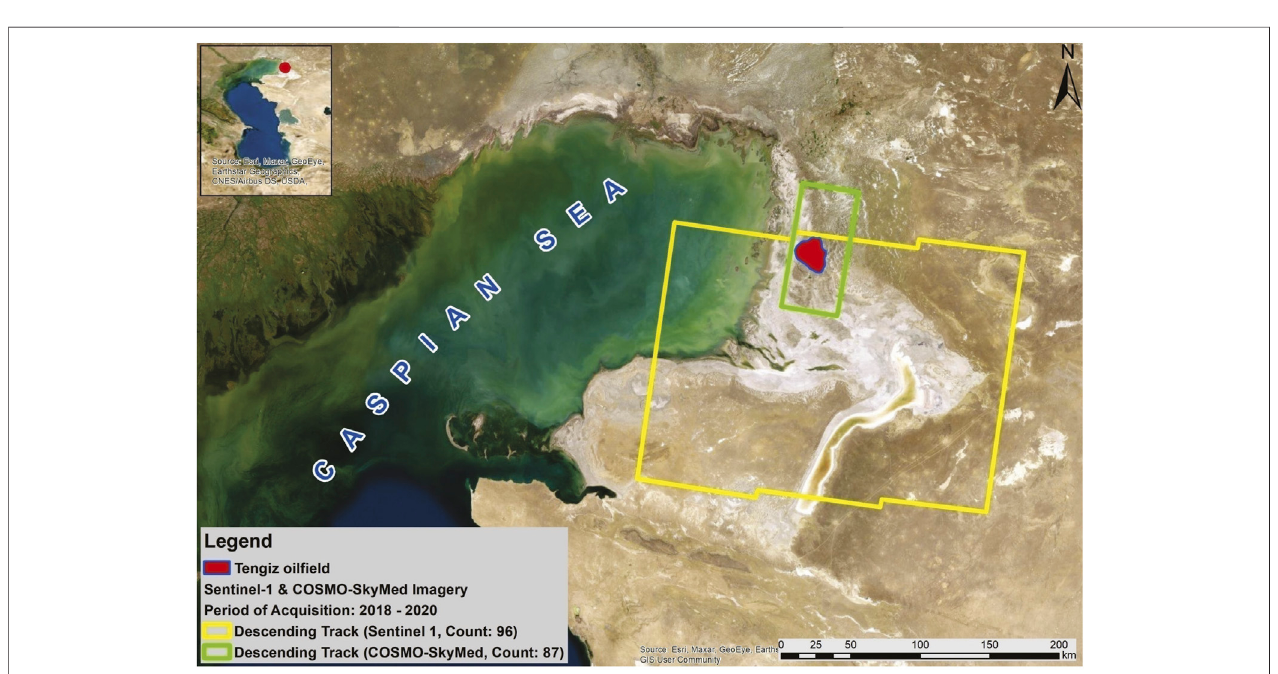
FIGURE 2 | Extents, count and acquisition period of Sentinel-1 and COSMO-SkyMed